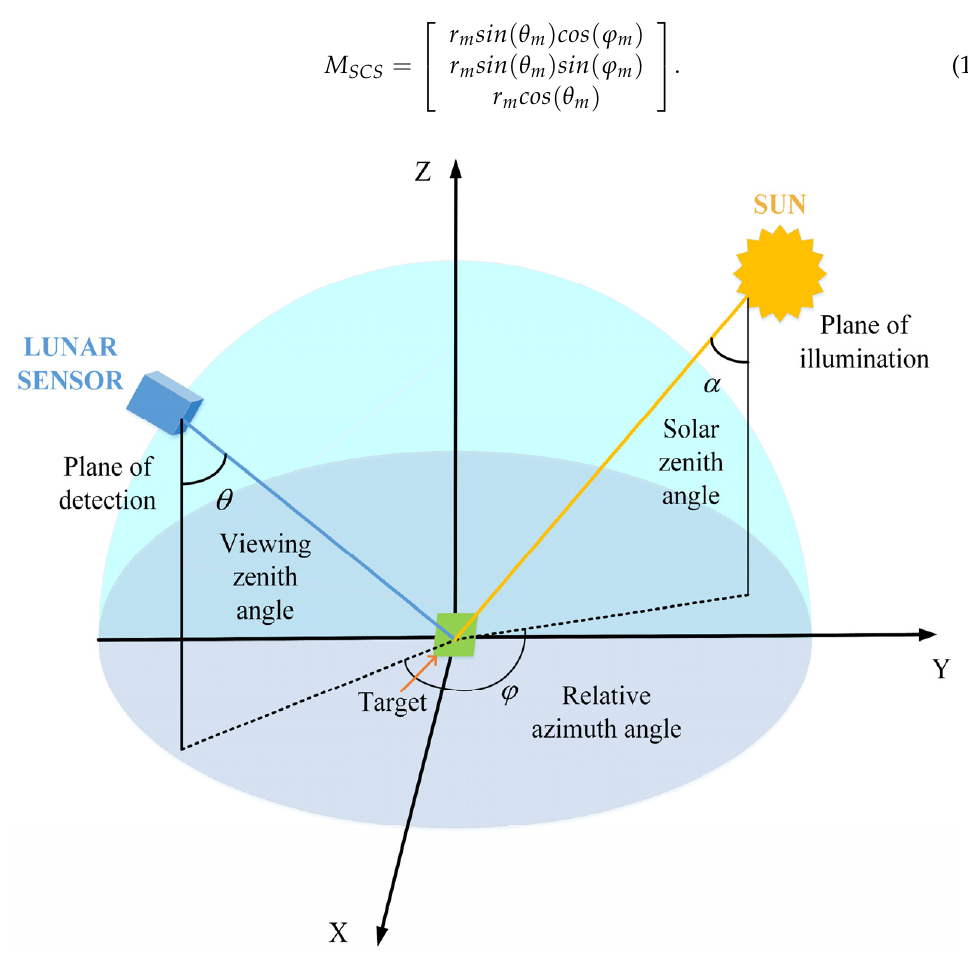
Figure 1. Schematic of the observational angles.